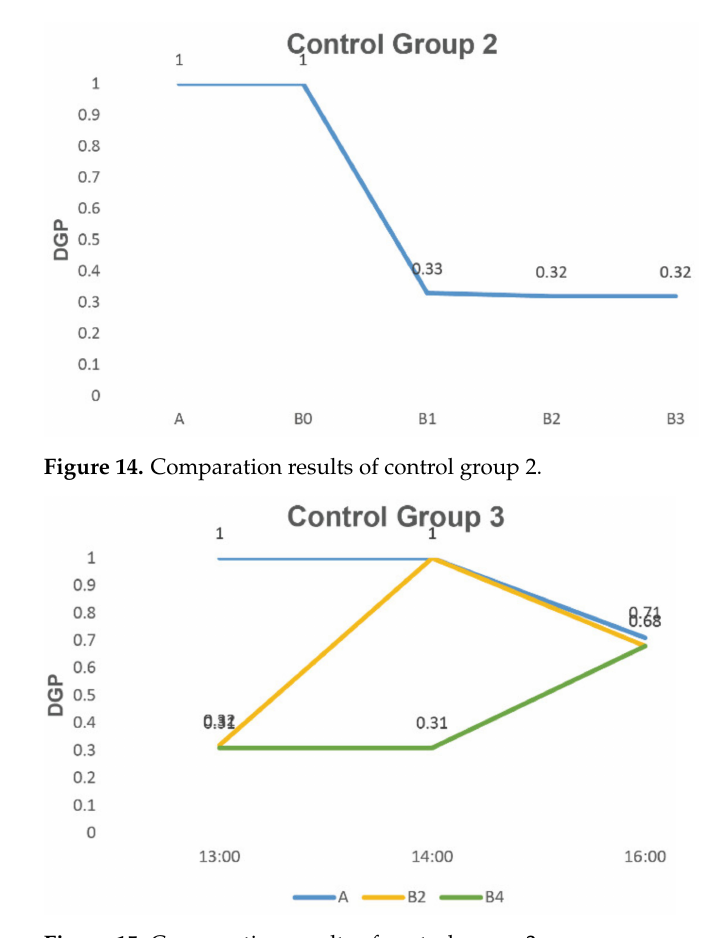
Figure 15. Comparation results of control group